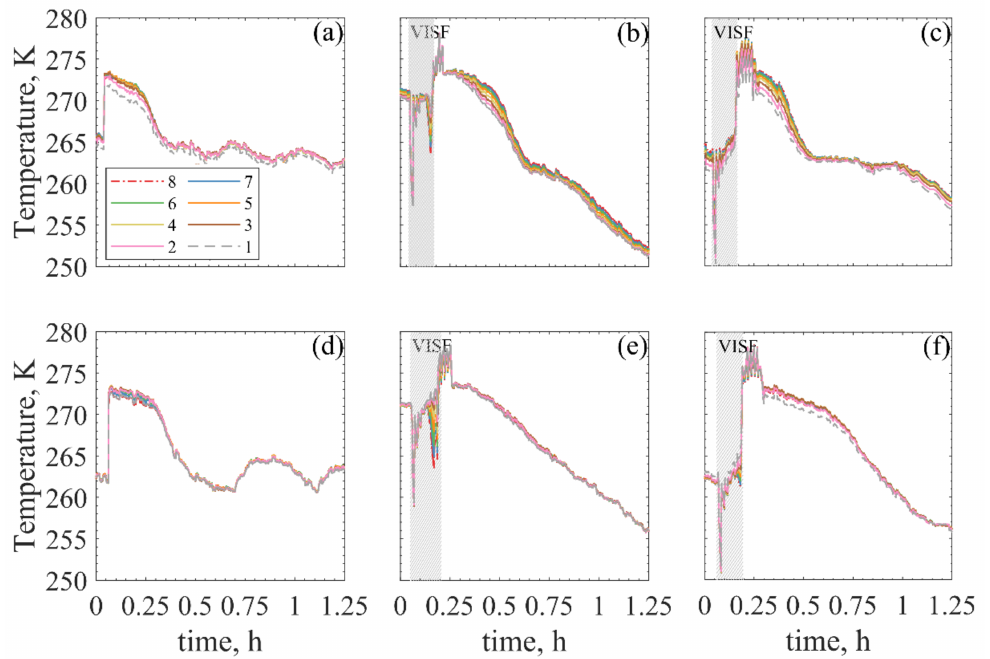
Figure 4. Axial temperature profiles during freezing of 5% sucrose. The top graphs ( a – c ) are ON-shelf, while bottom graphs ( d – f ) are OFF-shelf. ( a , d ) Spontaneous nucleation, ( b , e ) VISF 271 K, ( c , f ) VISF 263